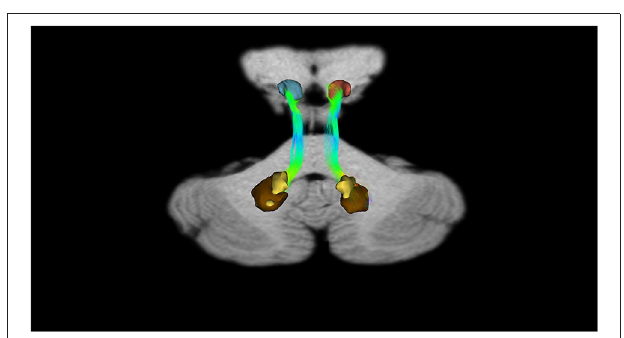
FIGURE 7 | Dentate-VTA interconnections. Coronal view shows the interconnections between the right dentate nucleus and the ipsilateral and contralateral VTA, and the left dentate nucleus and the ipsilateral and contralateral VTA. The fibers exited the cerebellum via the right and left superior cerebellar